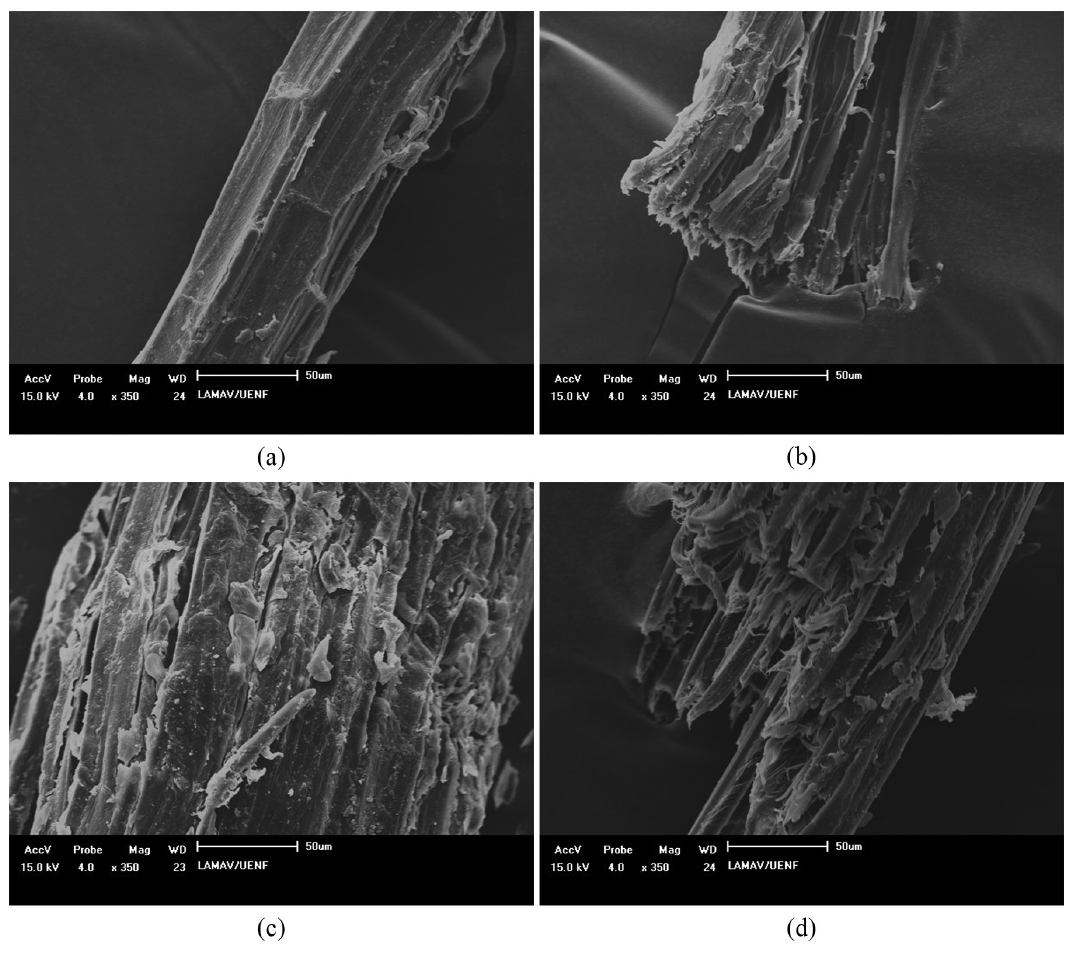
Figure 9. SEM micrographs of PALF. Thinner fiber, d = 0.11mm: (a) general aspect and (b) fracture tip. Thicker fiber, d = 0.25 mm: (c) general aspect and (d) fracture tip.